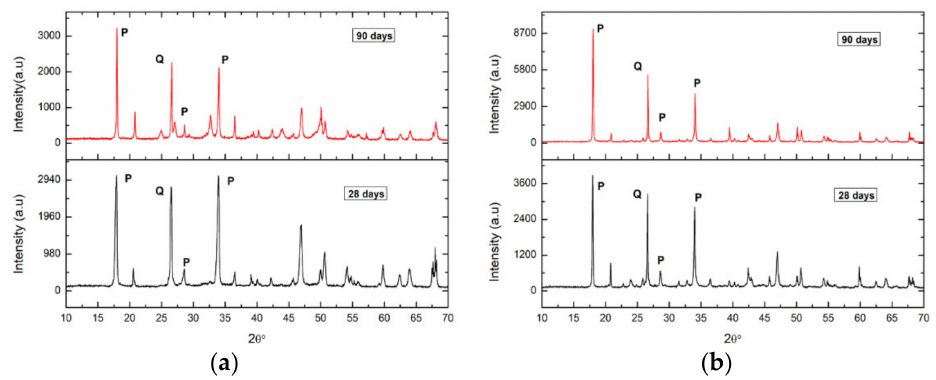
Figure 13. Graph that represents the evolution of carbonation over time of the internal zone of a mortar for Group In ( a ). Graph that represents the evolution of carbonation over time of the internal zone of a mortar for Group IIn ( b ). P: Portlandite, Q: Quartz, C: Calcite. Table 7. Ratio of intensities of the Ca(CO 3 ) diffraction peak with respect to the Ca(OH) 2 peak given by the parameter B for the In and IIn specimen groups of the zone closest to the surface. GROUP IN Group